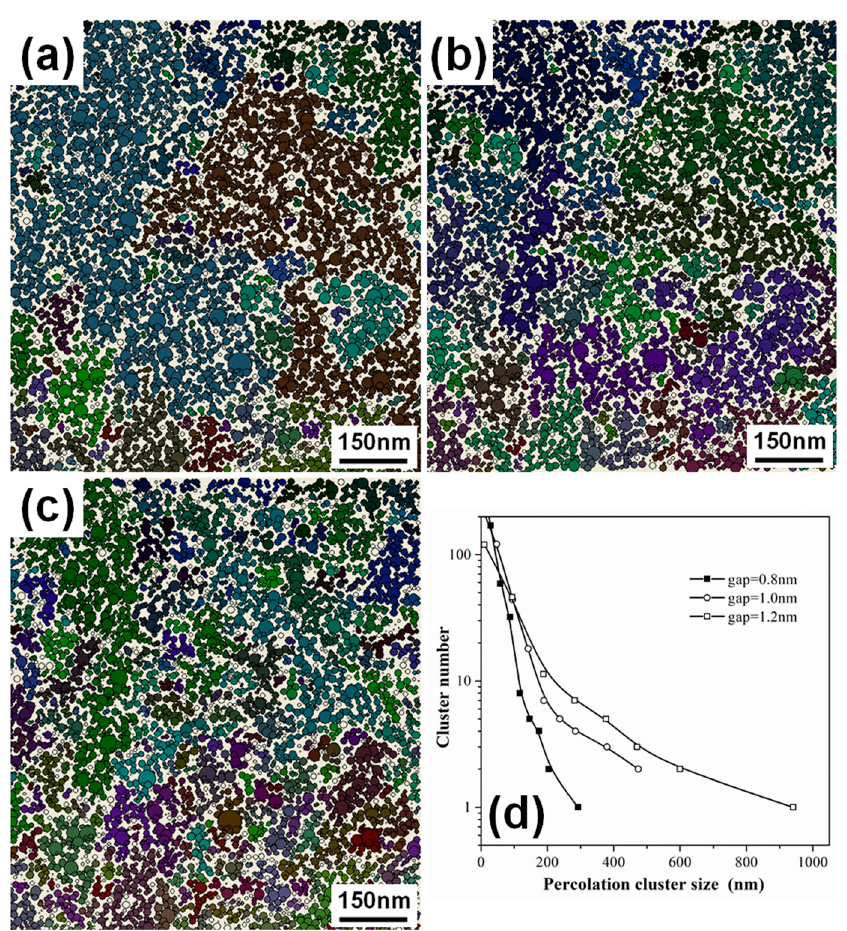
Figure 6. Digitalized NP location mappings generated from the TEM image of the Pd NP film with deposition time of 350 s. The percolation clusters are searched by assuming a critical separation gap for electron conduction of ( a ) 0.8 nm, ( b ) 1.0 nm and ( c ) 1.2 nm, respectively. Each percolation cluster is marked with different colors. ( d ) Size distributions of the percolation clusters in ( a – c ).